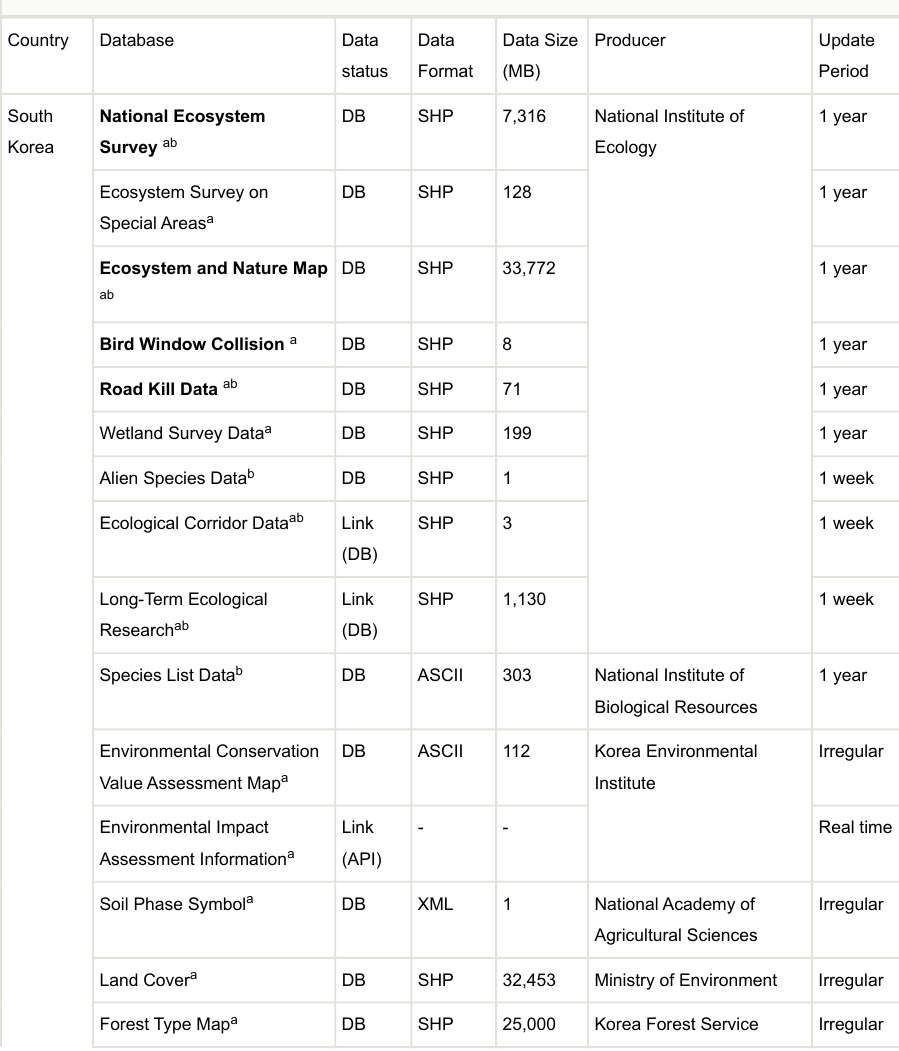
An overview of structured data in EcoBank. There are four types of data status: data stored in a database server (DB), data implemented through a link with DB servers or API of other data platforms (Link), data implemented through a GIS server (GIS) and data opened in a test server (Test). Databases, which have datasets currently opened with assigned DOI, are in bold type. Data format and size indicate that the format and size of raw data are stored in databases of EcoBank. Data opened only in a test server and linked by API sevices were excluded from the size